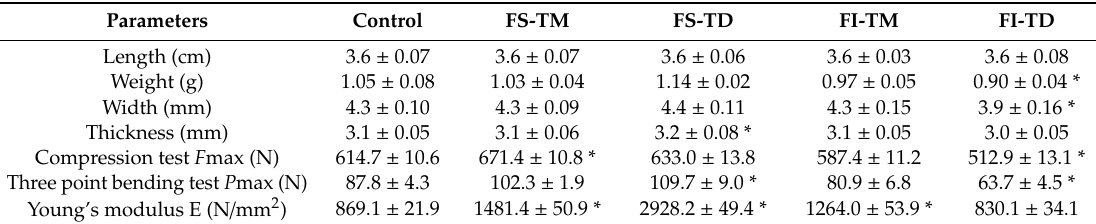
Table 4. Physical and mechanical properties of the femurs in rats fed with the experimental diets.